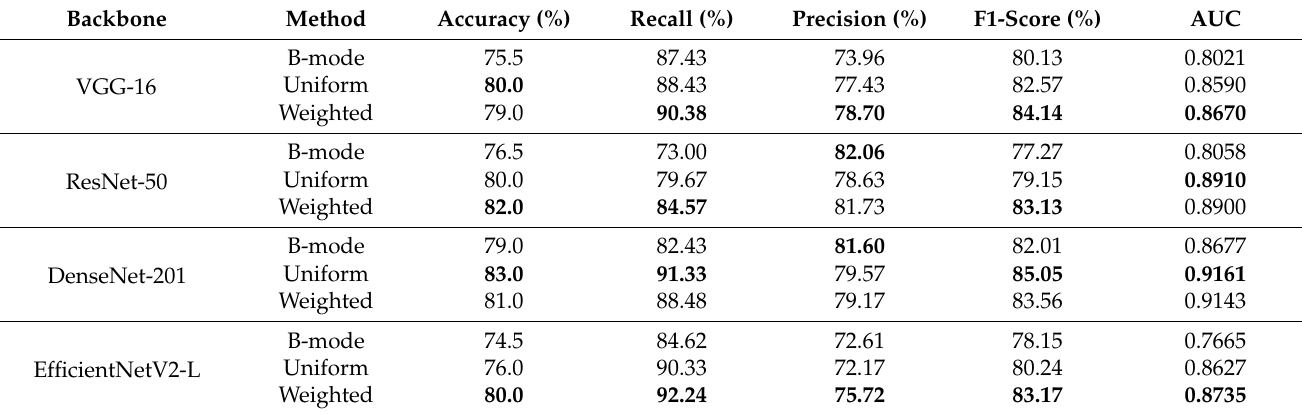
Table 2. Classification performances of the proposed ensemble CNN